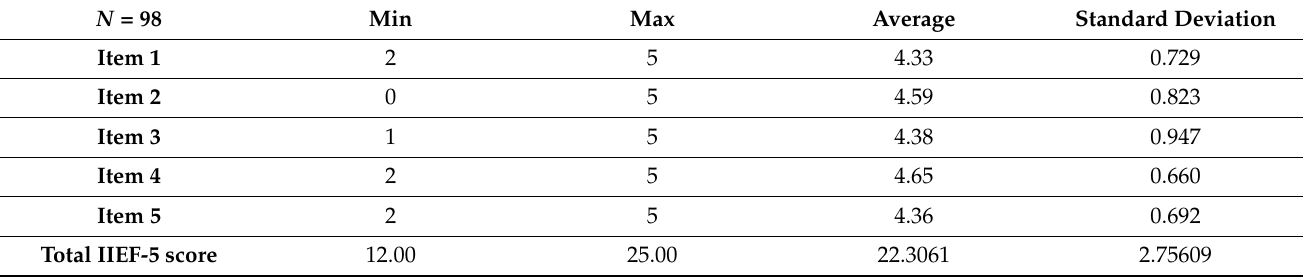
Table 1. Result of the scores obtained in the Spanish version of the IIEF-5. N = 98 Min Max